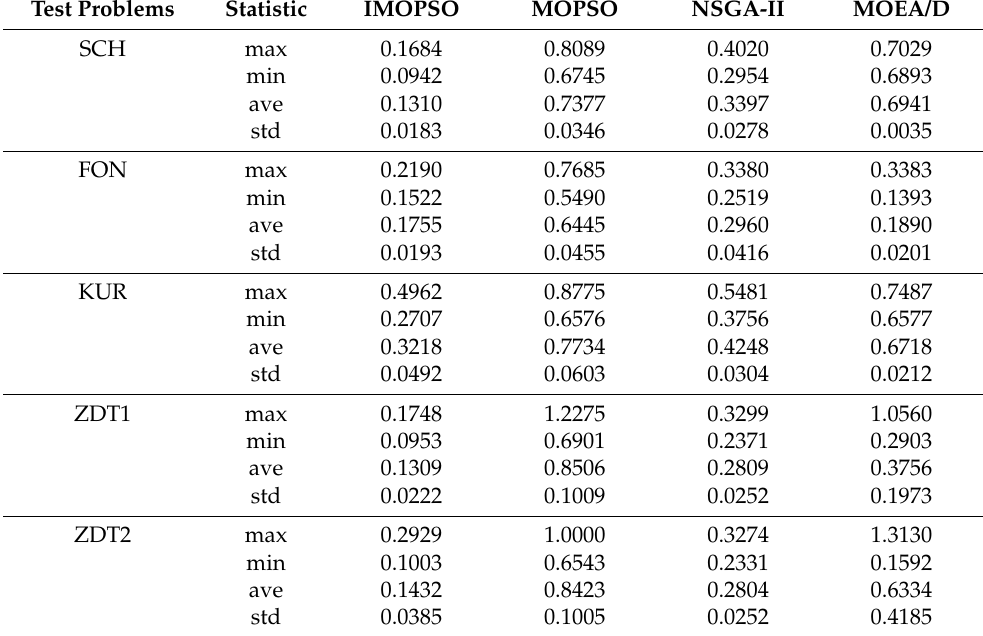
Table 3. Comparison of the ∆ index of four